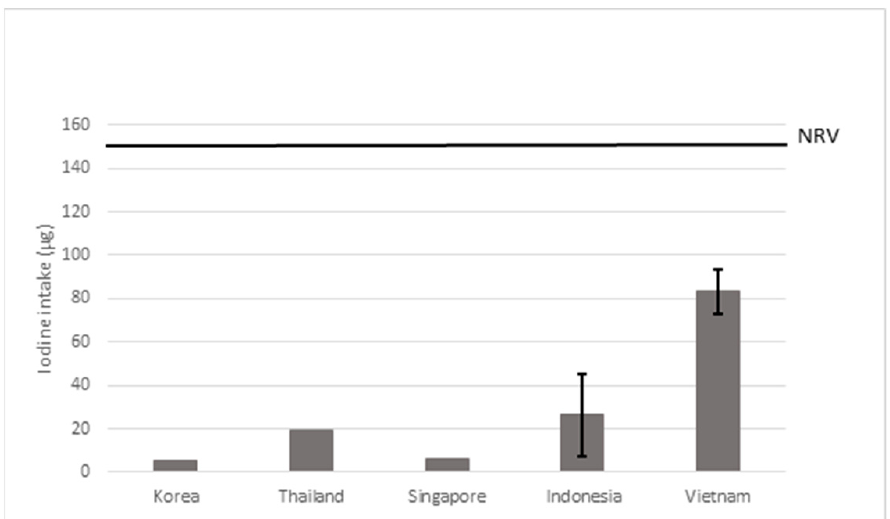
Figure 5. Estimated iodine intake after hypothetical fortification of seasonings and bouillon cubes with 30 µg of iodine/g of salt. The error bars represent the highest and lowest value found for the country. NRV = Codex nutrient reference value of 150 µg/day.